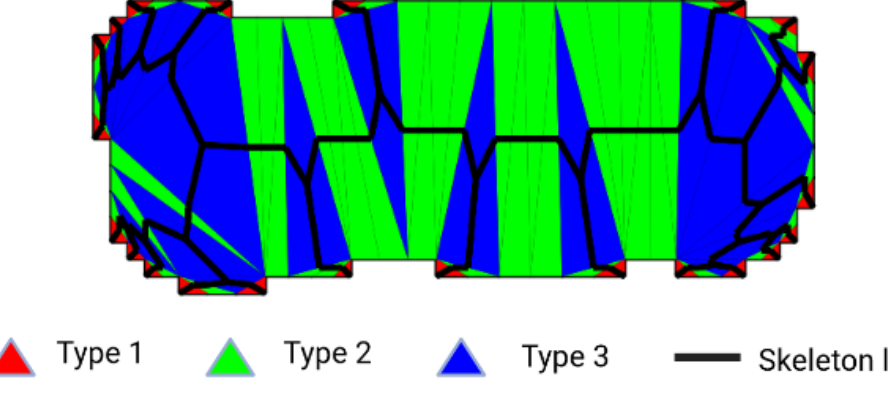
Figure 3. Skeleton line extraction based on CDT.